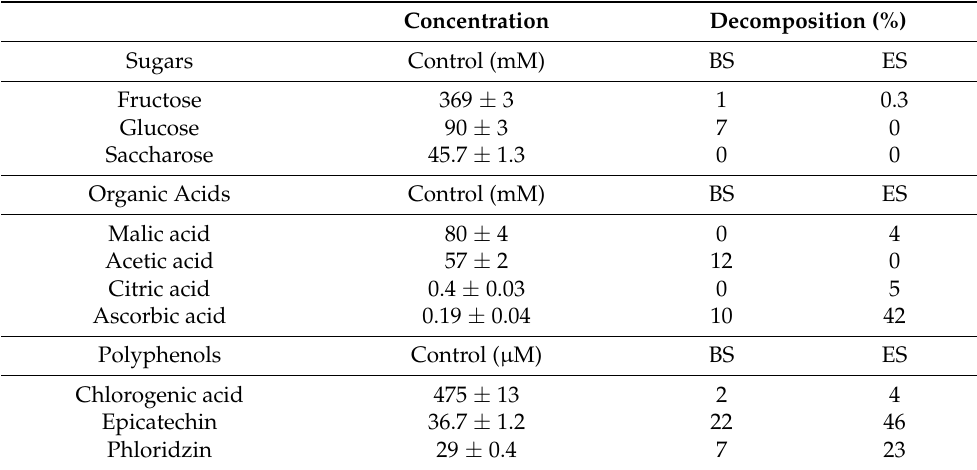
Table 2. Decomposition of the main organic juice components post plasma exposure (mean ± SD, n = 3) in the electrospray system (ES) and batch system (BS).